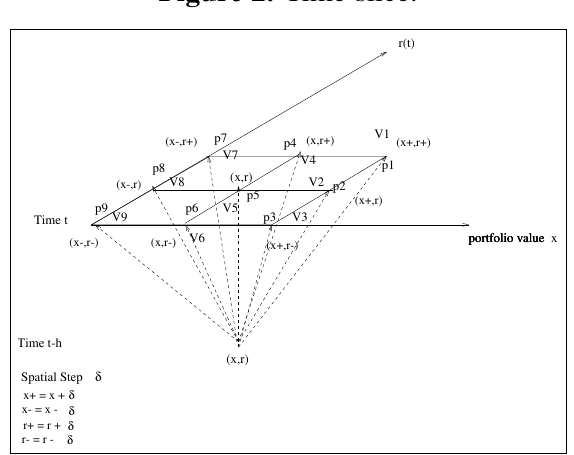
Figure 2. Time slice.